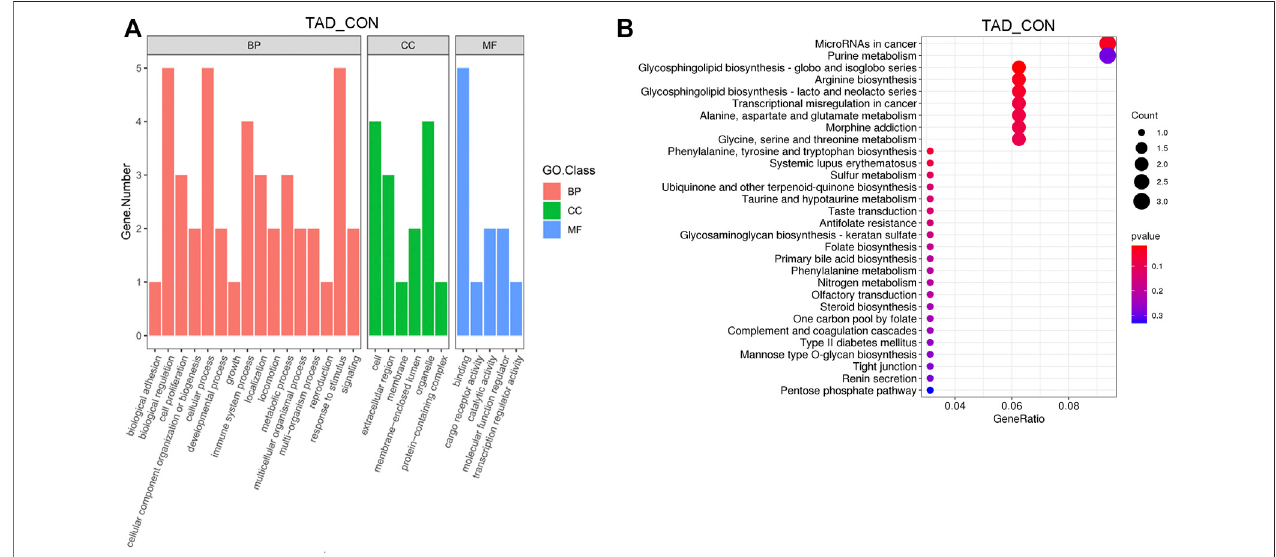
FIGURE 3 | Functional enrichment analysis of DEGs. (A) Functional enrichment clustering analysis of DEGs was performed by top GO terms in biological process, cellular component, and molecular function. (B) Bubble chart of the KEGG pathways (top 30) that DEGs signi fi cantly involved in. The rich factor is de fi ned as the ratio of the number of DEGs to the total number of genes enriched in a speci fi c category. The count of DEGs was roughly represented by the size of circles. Log10-adjusted p -value was indicated by thecolor saturation from green to red. GO, Gene Ontology; BP, biological processes; CC, cellular components; MF, molecular functions; KEGG, Kyoto Encyclopedia of Genes and Genomes; DEGs, differentially expressed genes. p -value <